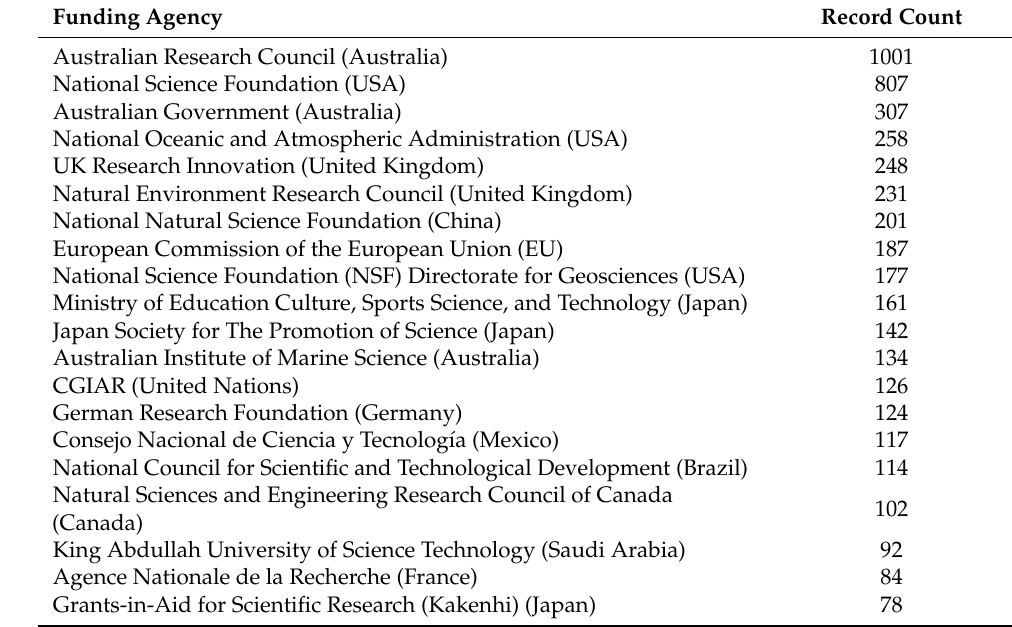
Table 2. Top 20 funding agencies related to coral reef and climate-change-related